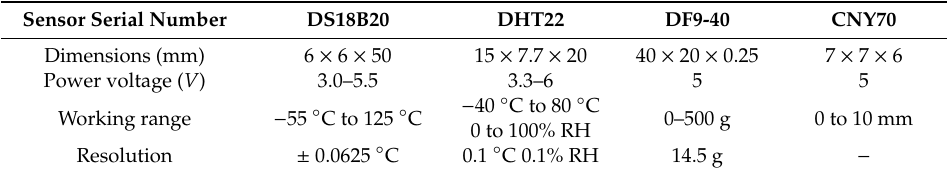
Table 2. Technical specifications of the